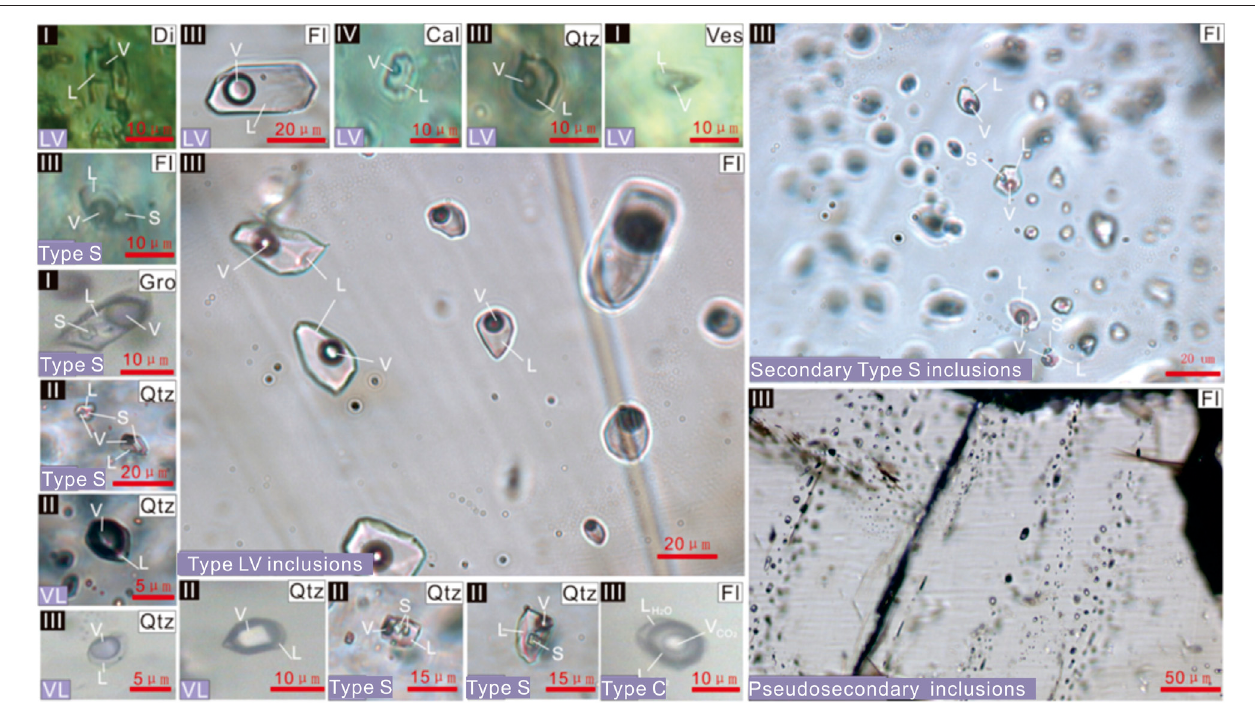
FIGURE 4 | Photographs of various types of fl uid inclusion of each ore-forming stage of the Gejiu Sn – Cu polymetallic deposit. The symbol in the upper – left corner indicates the ore-forming stage, that in the upper – right corner indicates the host minerals, the one in the lower – right corner represents the type of fl uid inclusion. Cal – calcite, Di – diopside, Fl – fl uorite, Gro – grossular, Qtz – quartz, Ves – vesuvianite.